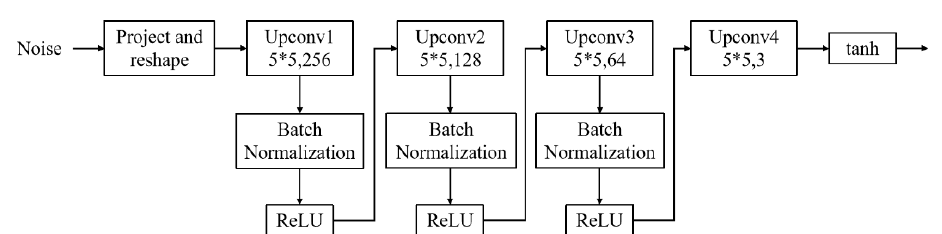
Figure 3. Frame diagram of the discriminator.